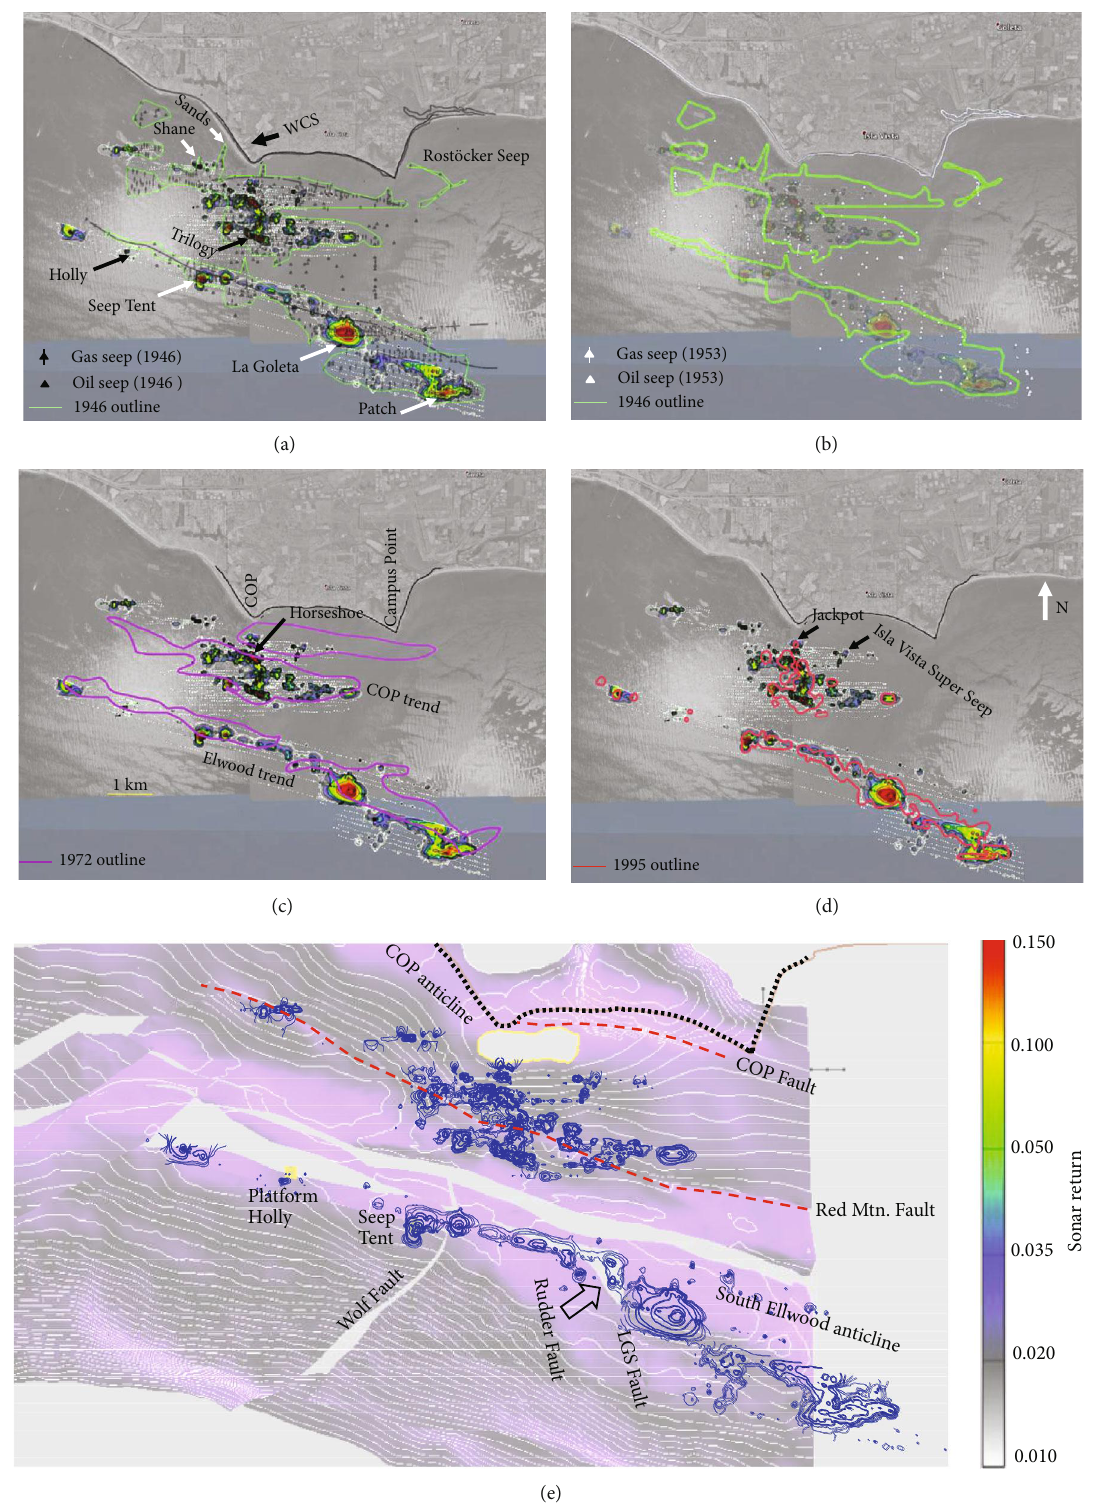
Figure 18: Sonar return map for 2005 from Leifer et al. [102]; white dots indicate survey lines. (a) 1946 gas seep area outline (this study) and mapped oil and gas seeps; (b) 1953 seep area outline (this study) and mapped gas and oil seeps; 2005 sonar data contrast lowered; (c) 1972 gas seep area outline from Fischer [50]; (d) 1995 gas seep area outline from Horna fi us et al. [260]. Displayed in Google Earth showing aerial image from Sept. 1994. (e) Monterey Formation (MF) depth and location of faults and 1995 sonar contours. See Figure 12 for MF depths and